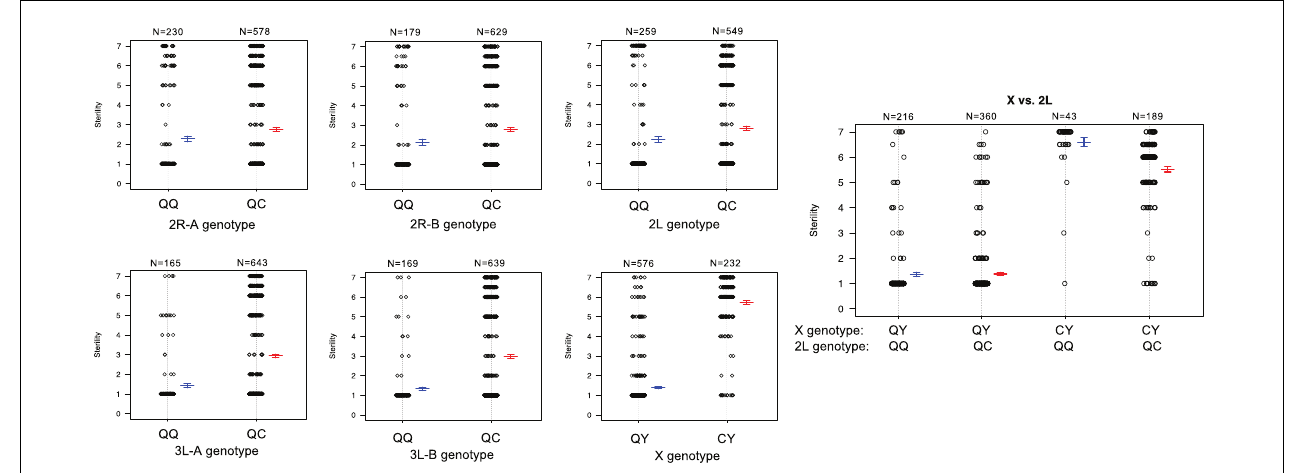
FIGURE 5 | Genotype ( x -axis) by phenotype (sterility score, y -axis) plots for the six QTL identified using CIM and multiple imputation, and an interaction plot (right) for the epistatic effect between the X chromosome and 2L QTL. Each individual is represented as a dot, which are jittered to avoid overlap. Box plots illustrate the mean (middle line) of each phenotype distribution and whiskers illustrate ± 1 standard error of the mean. QTL names and locations correspond to those in Table 2 . QQ, An. quadriannulatus homozygous; QC, An quadriannulatus/An. coluzzii heterozygous.